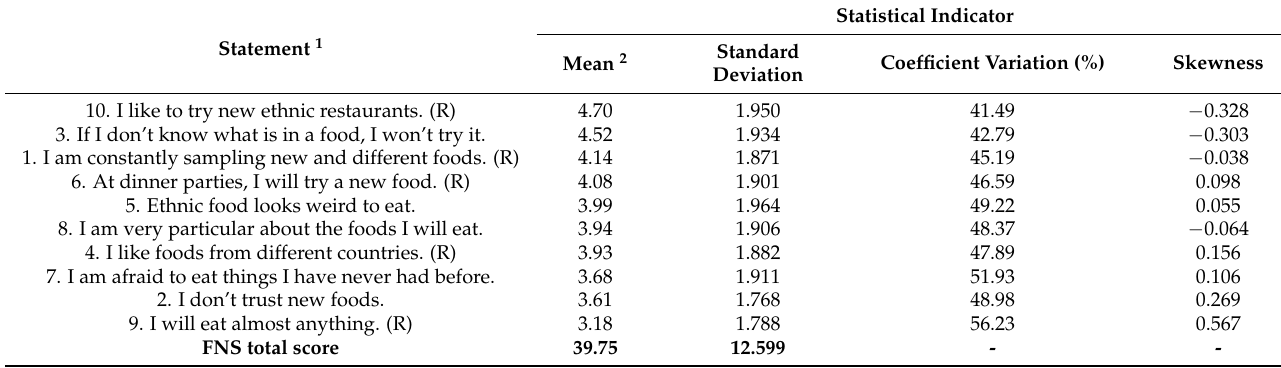
Table 2. Descriptive statistical indicators of the Food Neophobia Scale (FNS) ( n =